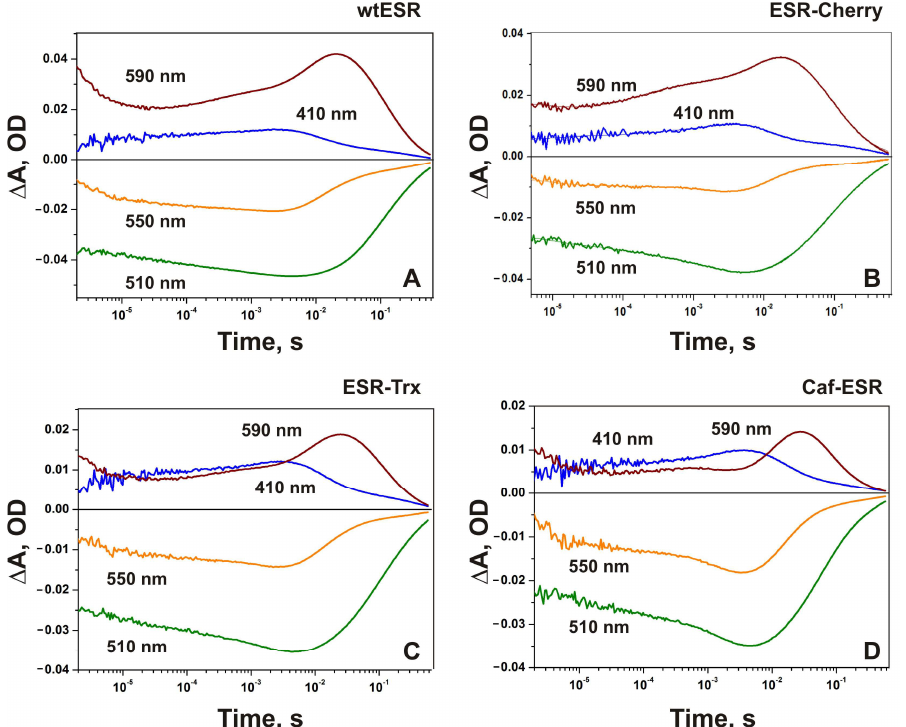
Figure 2. Light-induced absorption changes at four characteristic wavelengths (410 nm, 590 nm, 550 nm, and 510 nm) at pH 9.0 in DDM micelles containing: ( A ) wild-type ESR; ( B ) ESR-Cherry; ( C ) ESR-Trx; ( D ) Caf-ESR. Table 2. Time constants (ms) of the photocycle in wild-type ESR and the hybrid proteins in DDM micelles at pH